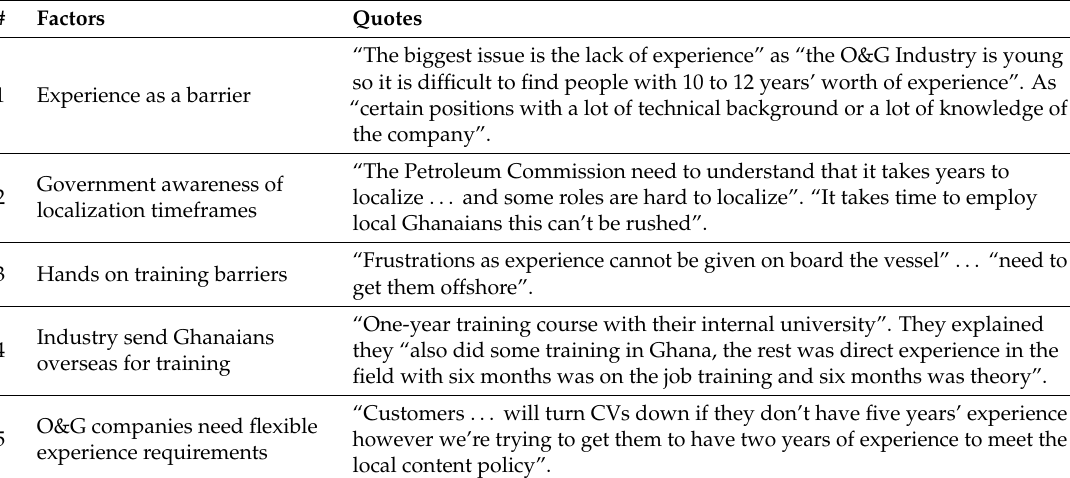
Table 6. ‘Experience and time to competency’ theme.